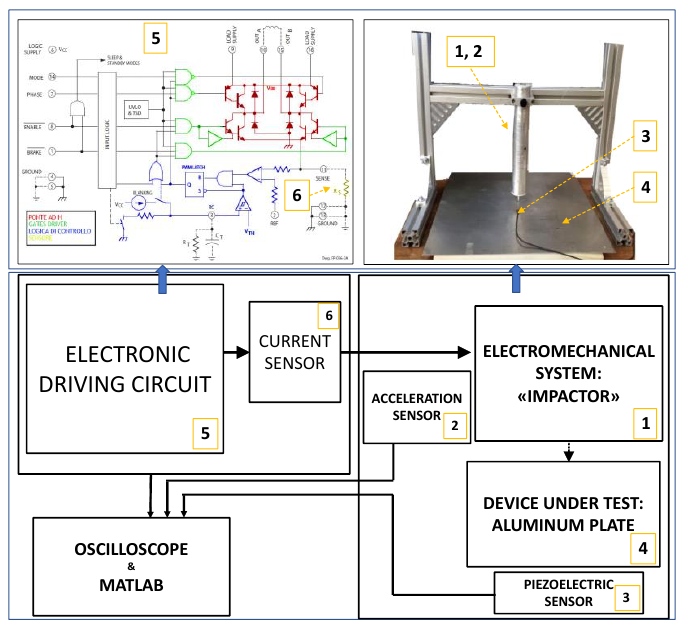
Figure 2. Set-up designed to generate controlled energy impacts: on the left side, the electronics that drives the electro-mechanical device and the instrumentation to acquire and process the data, on the right, the mechanical system that generates impacts and the plate under test.